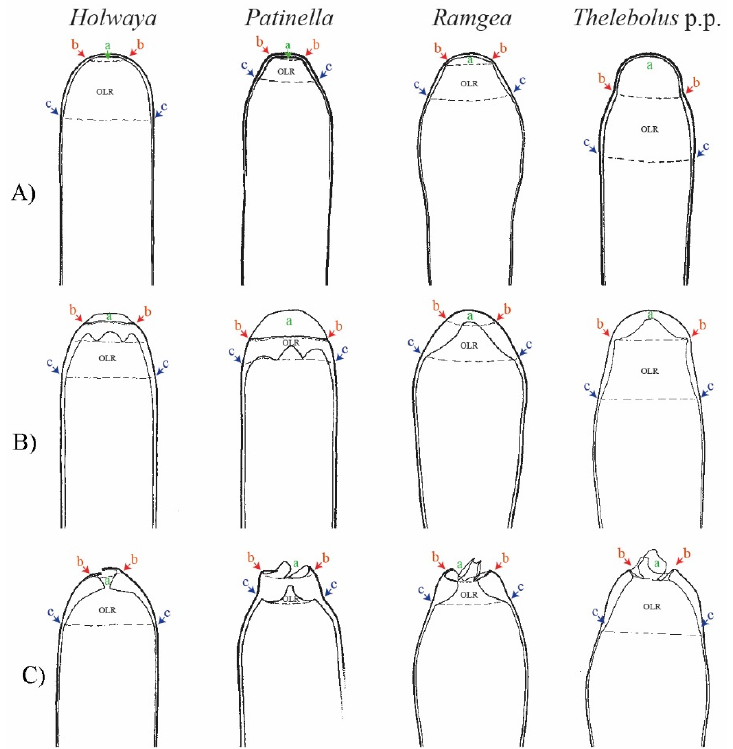
Figure 8. Asci apices with OLR-type dehiscence in Thelebolales species with forcible discharge asci: ( A ) mature ascus (ascal wall compressed by ascoplasm turgor); ( B ) mature ascus (ascal wall relaxed due to loss of turgor); ( C ) ↑ mature ascus displaying irregular (asymmetric) tear above OLR after ascospore discharge; a—opening apical zone above OLR; b—upper OLR line; c—lower OLR line. Compiled drawings are not presented to scale in order to fit the single plate. Del. N. Mato č ec.